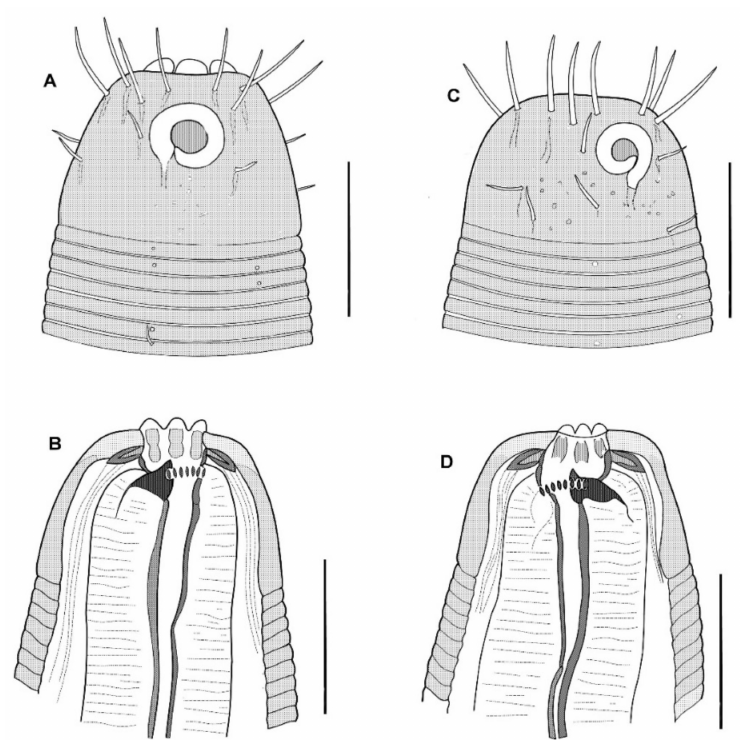
Figure 8. Acanthopharynx micans, anterior ends (sample PA13, sponge Cinachry a sp.): ( A )—male, surface view. ( B )—male, optical section. ( C )—female, surface view. ( D )—female, optical section. Scale bars 20 µ m.